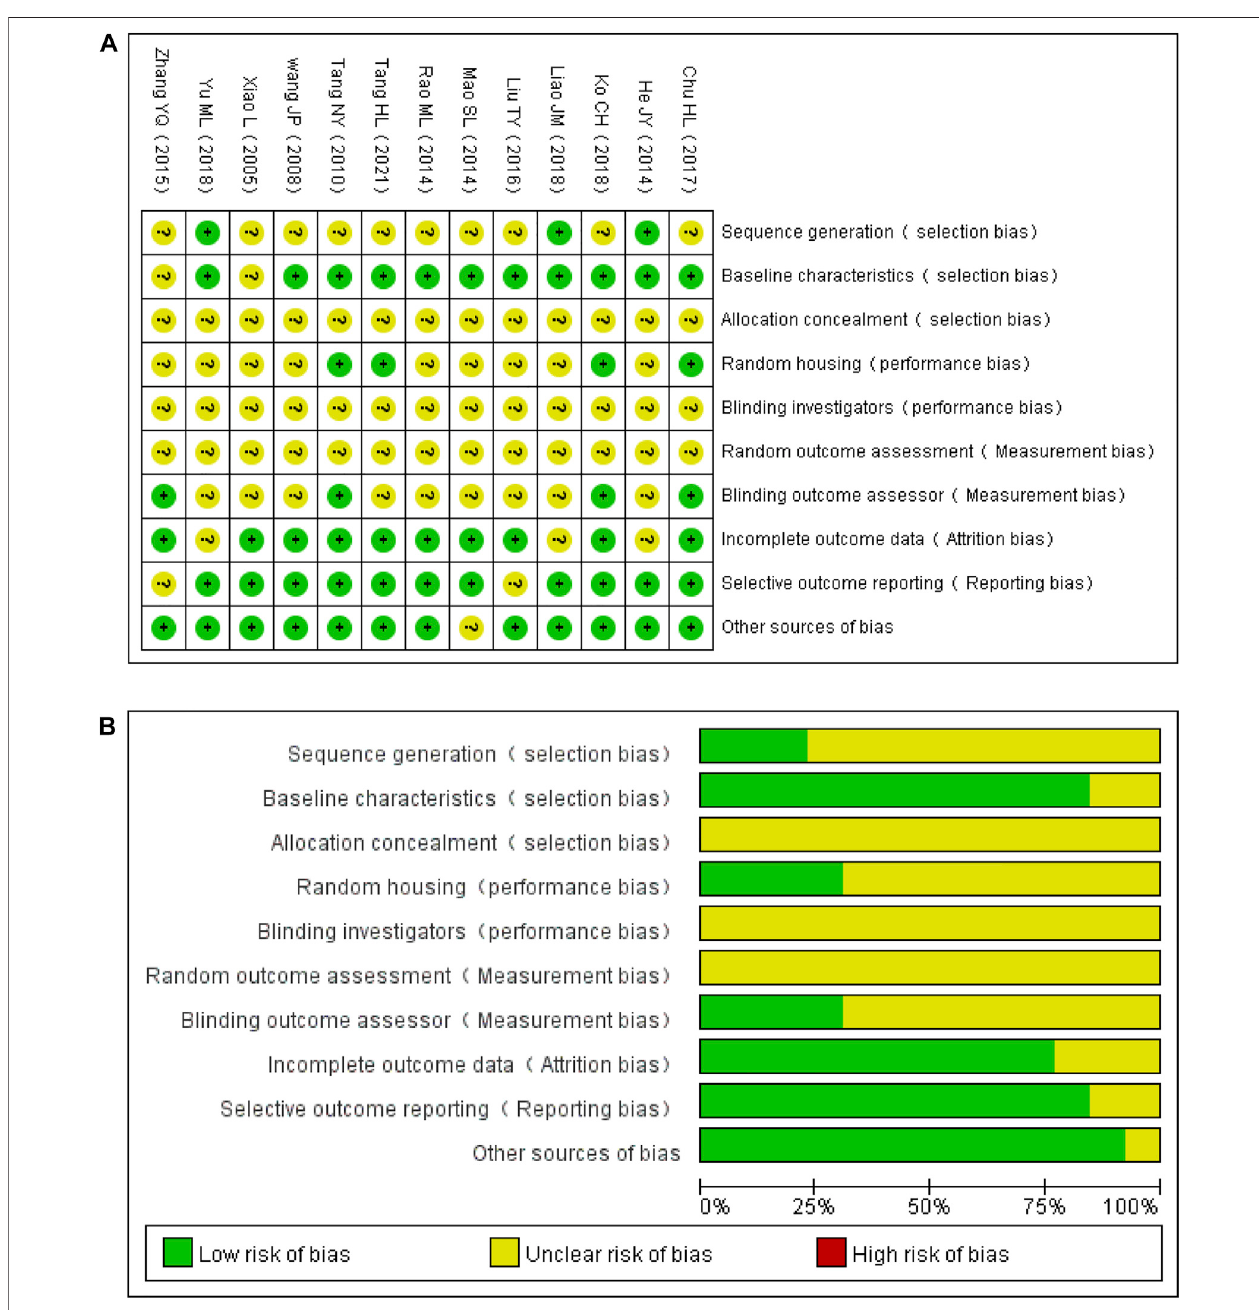
FIGURE 3 | Evaluation of the literature quality results obtained through SYRCLE ’ s risk of bias based on the Cochrane tool. (A) Risk of bias summary. (B) Risk of bias graph.